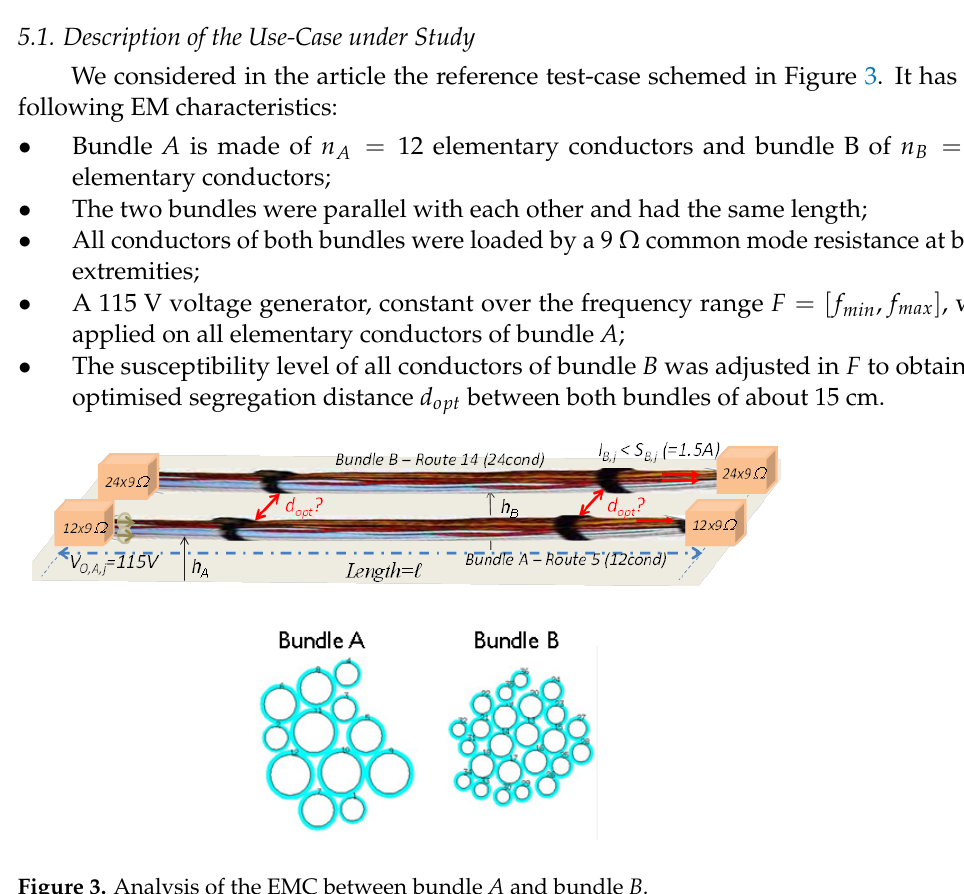
Figure 3. Analysis of the EMC between bundle A and bundle B